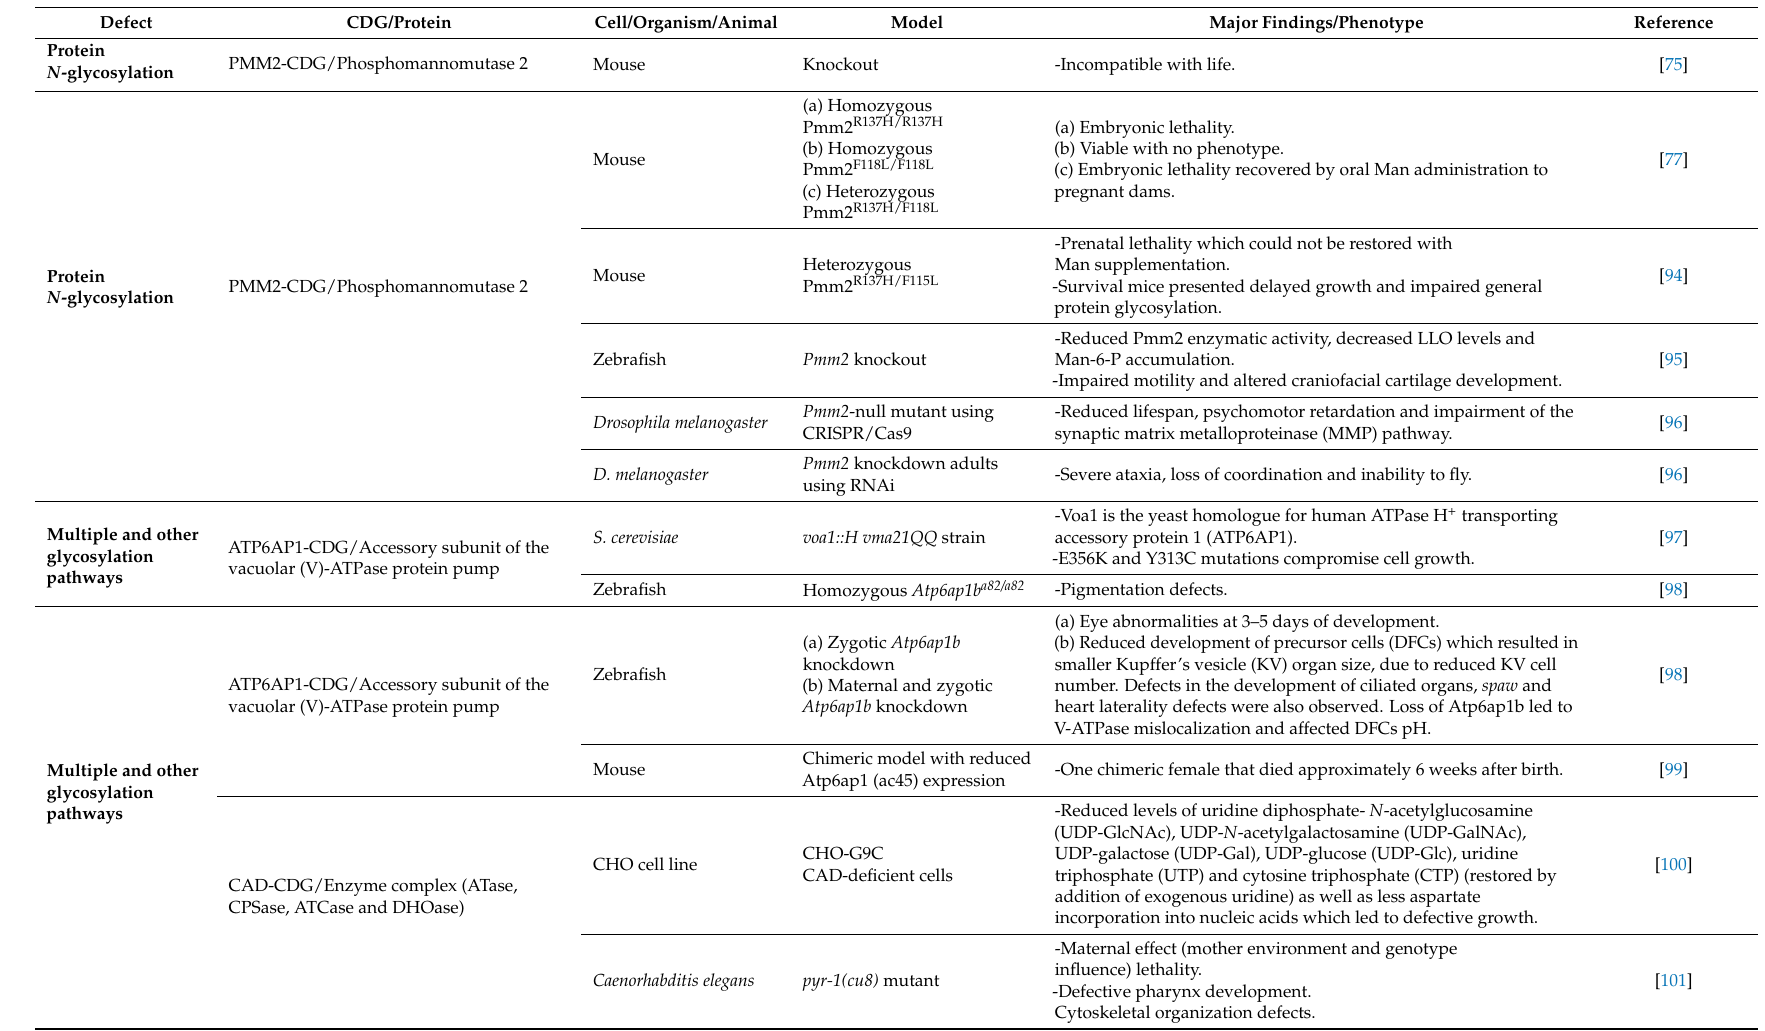
-Maternal effect (mother environment and genotype influence) lethality. -Defective pharynx development. Cytoskeletal organization